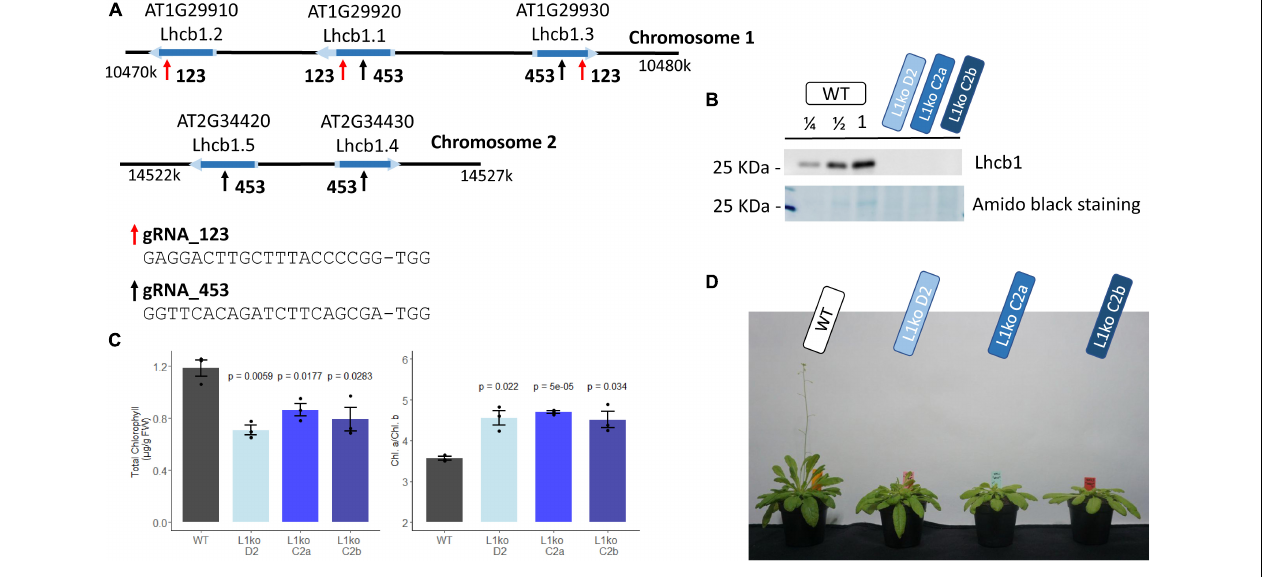
FIGURE 1 | Generation of total knock-out lines for the five genes encoding LHCB1. (A) Schematic representation of the Lhcb1 gene clusters, showing the regions targeted by the two sgRNAs; the sequence of the sgRNAs is reported below. (B) Protein accumulation of the produced mutant lines; the representative immunoblot shows the detection of LHCB1 in a dilution series of WT total protein extract and in the L1ko mutants. Below, the staining of the membrane with amidoblack shows the differential band at 25 KDa that corresponds to the LHCII protein. (C) Total Chl accumulation normalized over the plant fresh weight, left, and the Chl a / b ratio, right, in WT and in the three L1ko mutant lines. The error bar indicates the standard error, and individual replicates are plotted as points ( n = 3) above each L1ko line are reported the p -value of a Student’s t -test comparison with WT. (D) The representative flowering phenotype of adult plants of the WT and the three independent L1ko